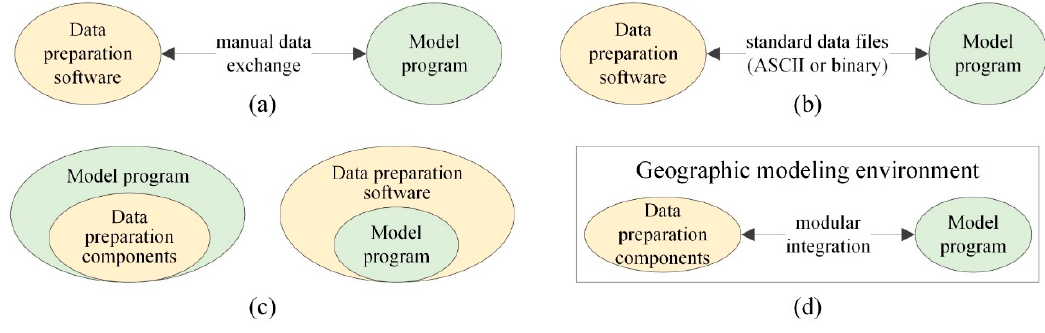
Figure 2. Coupling strategies for integrating data preparation tools with the model program: ( a ) Stand-alone, ( b ) loose coupling, ( c ) tight coupling, and ( d ) full integration.